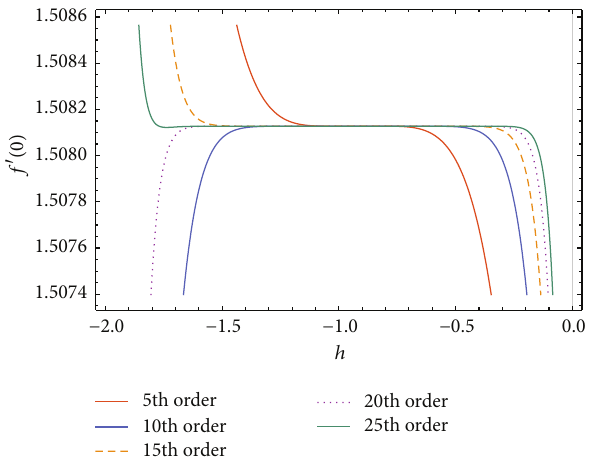
Figure 1: ℎ - curve of different order solutions for 𝑚 ℎ = 0.3 , 𝑚 𝑝 = 0.7 , and 𝑅 𝑚𝑝 = 1 .